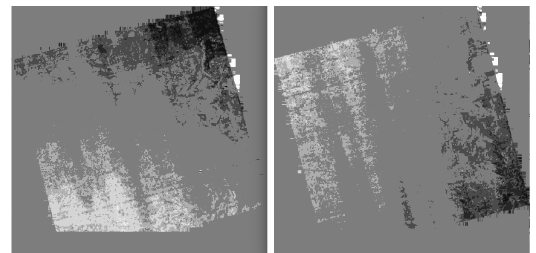
Figure 7: Oregon; residual transverse parallaxes computed for along-track stereo pair with the matching interval of 0.05 pix. Left: the D 0 ; right: the D 1 , scenarios. The parallax’s magnitudes are found in Tab. 4.